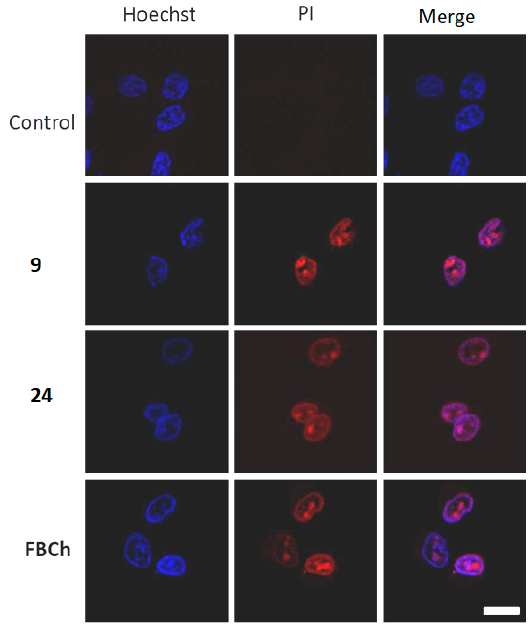
Figure 5. PI entry (necrosis) after light excitation of HCT116 cells loaded with indicated compounds for 24 h (10 μ M). Photoexcitation was carried out with the microscope laser for 5 min at 405 nm for 9 , 24 and FBCh. Bar, 15 μ m.